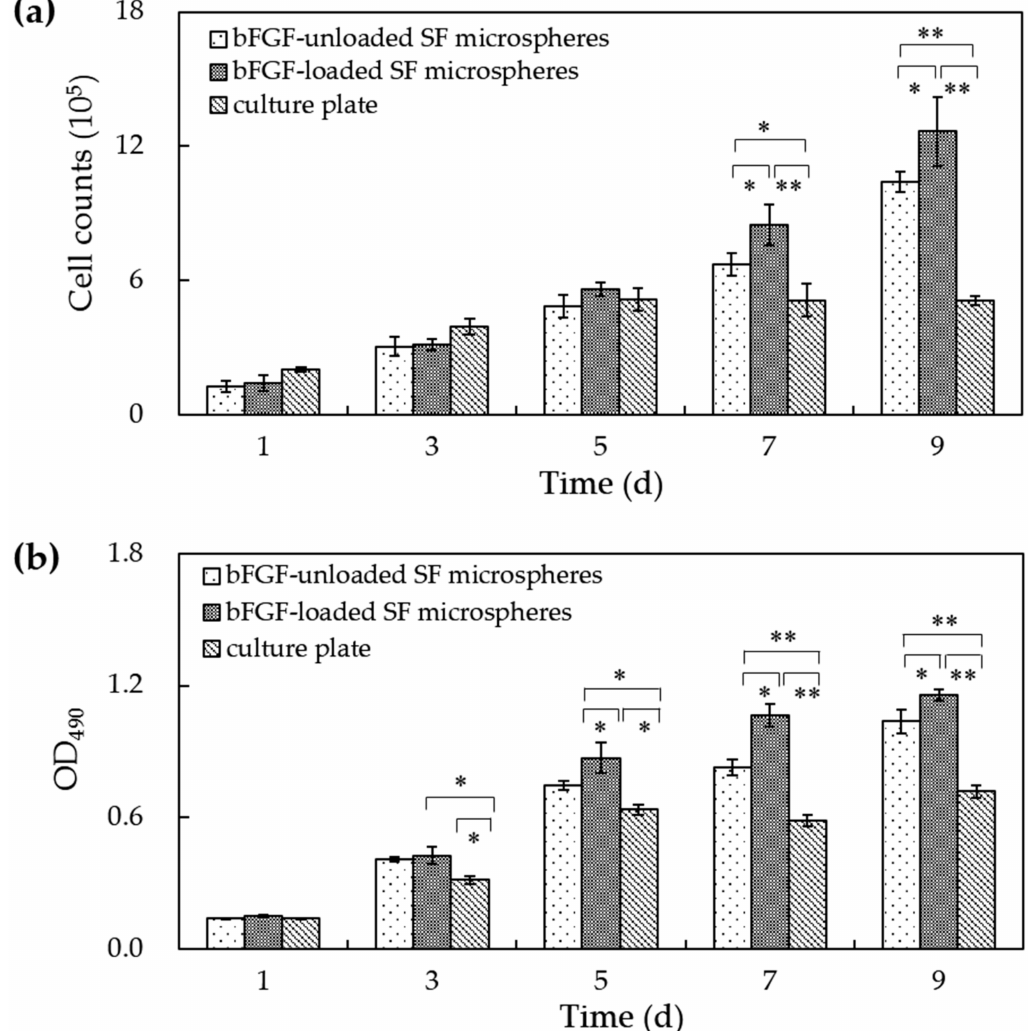
Figure 5. ( a ) The cell number and ( b ) cell viability on bFGF-loaded SF microspheres. (*: p < 0.05; **: p <